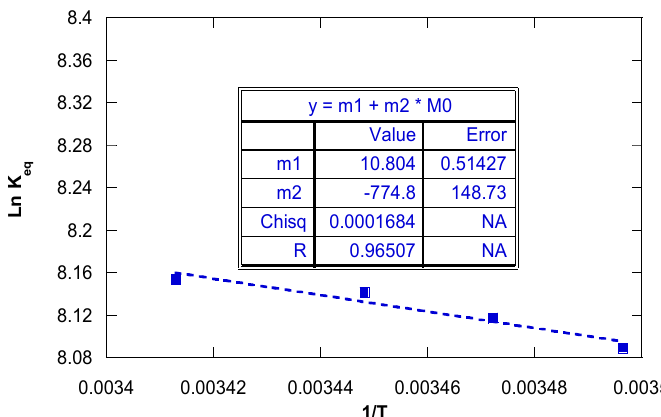
Figure 4. The plot of LnK